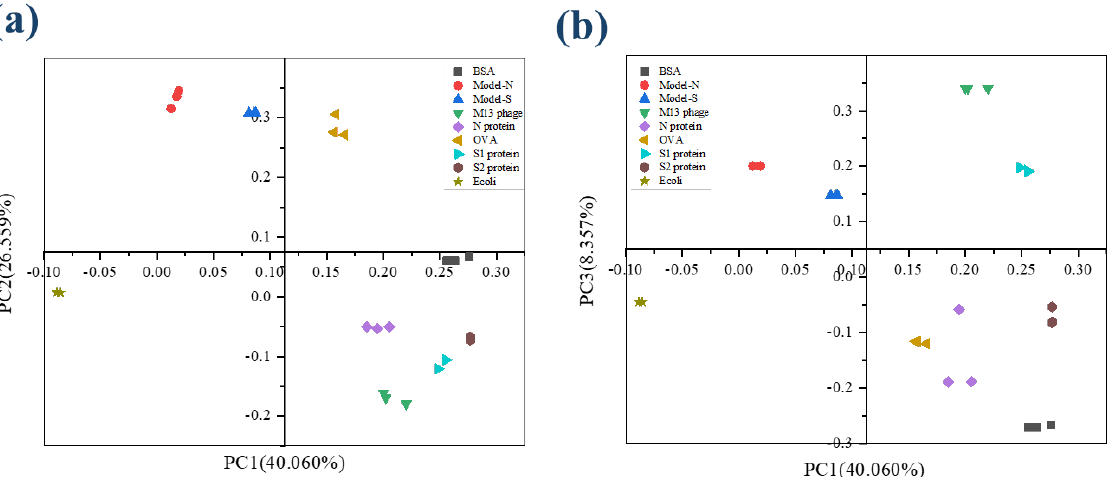
Figure 2. The score plot for the nine samples from 3DFS after PCA analysis. ( a ) Coordination PC1 − PC2; ( b ) Coordination PC1 − PC3. Table 3. Functions summarized from LDA and validation for 3DFS.